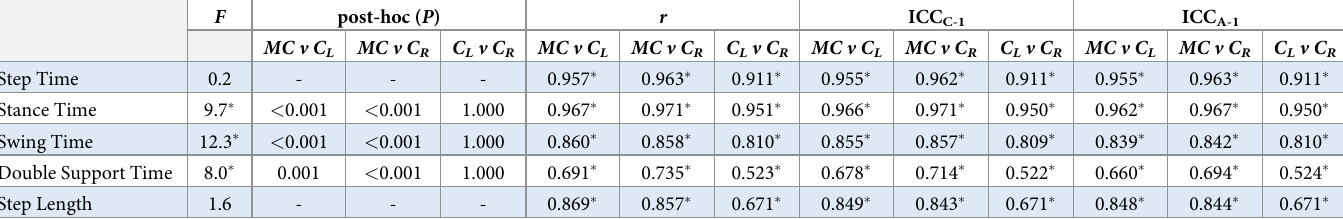
Table 3. Statistical tests for gait parameters calculated for all steps. MC : motion capture; C L : OpenPose left-side view; C R : OpenPose right-side view. Asterisks ( � ) denote P < 0.05. F post-hoc ( P